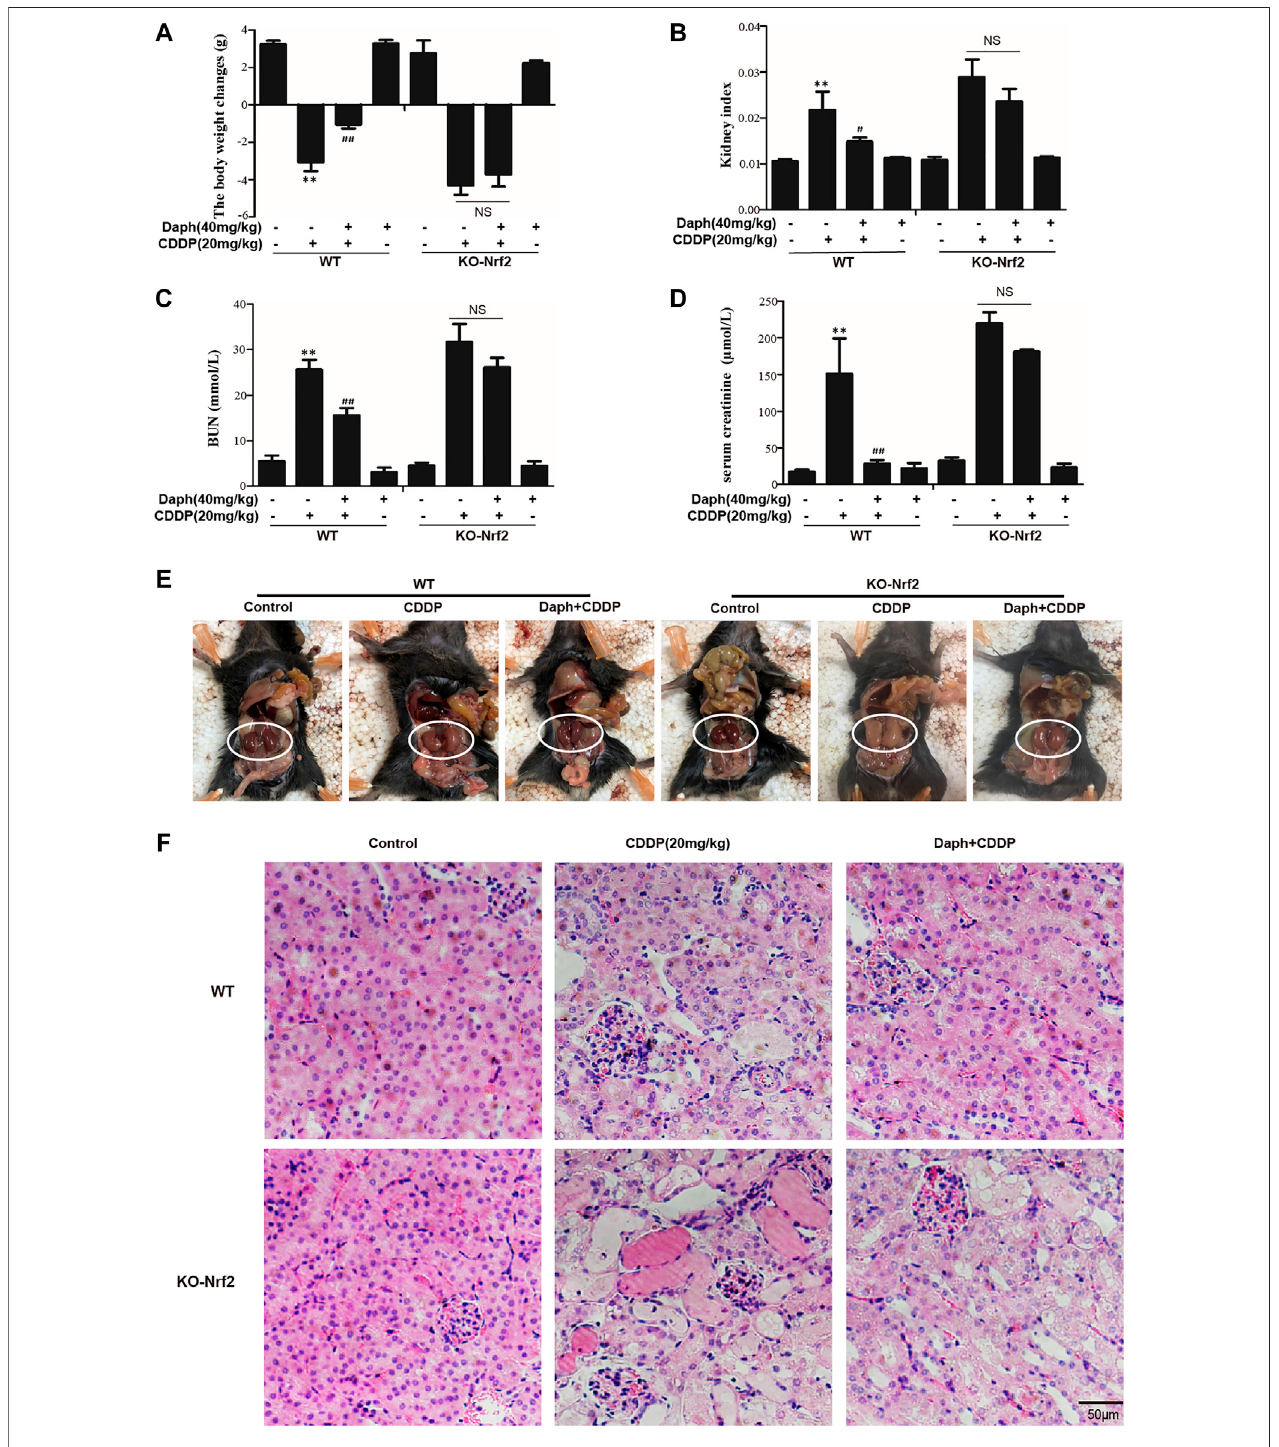
FIGURE 5 | Nrf2 is regulated by Daph relieved CDDP-induced AKI in mice. Mice were treated with Daph (40 mg/kg) or NAC (50 mg/kg) once a day for three consecutive days. CDDP (20 mg/kg) was administered once at 1 h after the fi rst Daph or NAC injection. Mice were sacri fi ced at 72 h after the CDDP administration. (A) Bodyweightand (B) Kidney/bodyweightratioofWTandNrf2 − / − mice. (C,D) BUNandserumcreatinineofWTandNrf2 − / − miceweremeasured. (E) macroscopickidney and (F) hematoxylinand eosin(H&E). (G) Western blotsanalysisshowingthe expression levels ofprotein in thekidneys fromofWT andNrf2 − / − mice.* p < 0.05and ** p < 0.01 vs. the CDDP group; ## p < 0.01 vs. the control group; NS, not signi fi cant.